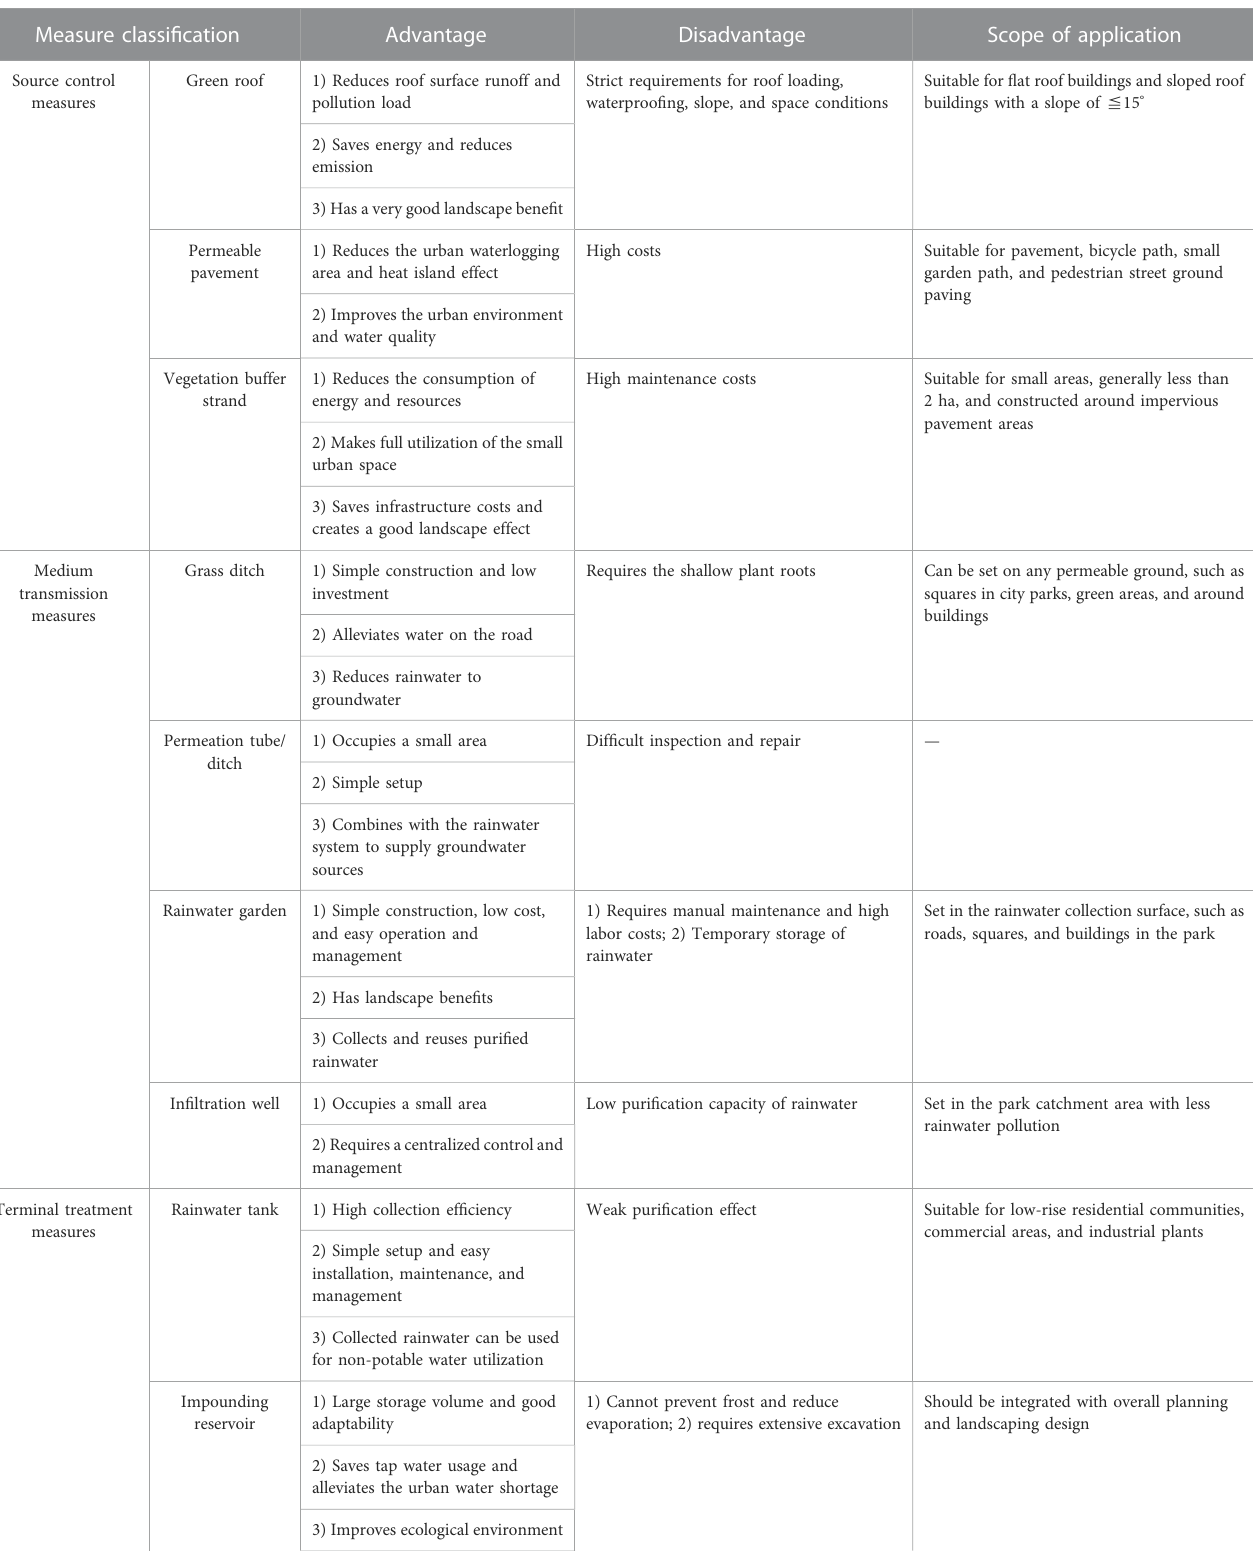
TABLE 2 Advantages, disadvantages, and the scope of application for the technical measures of rainwater